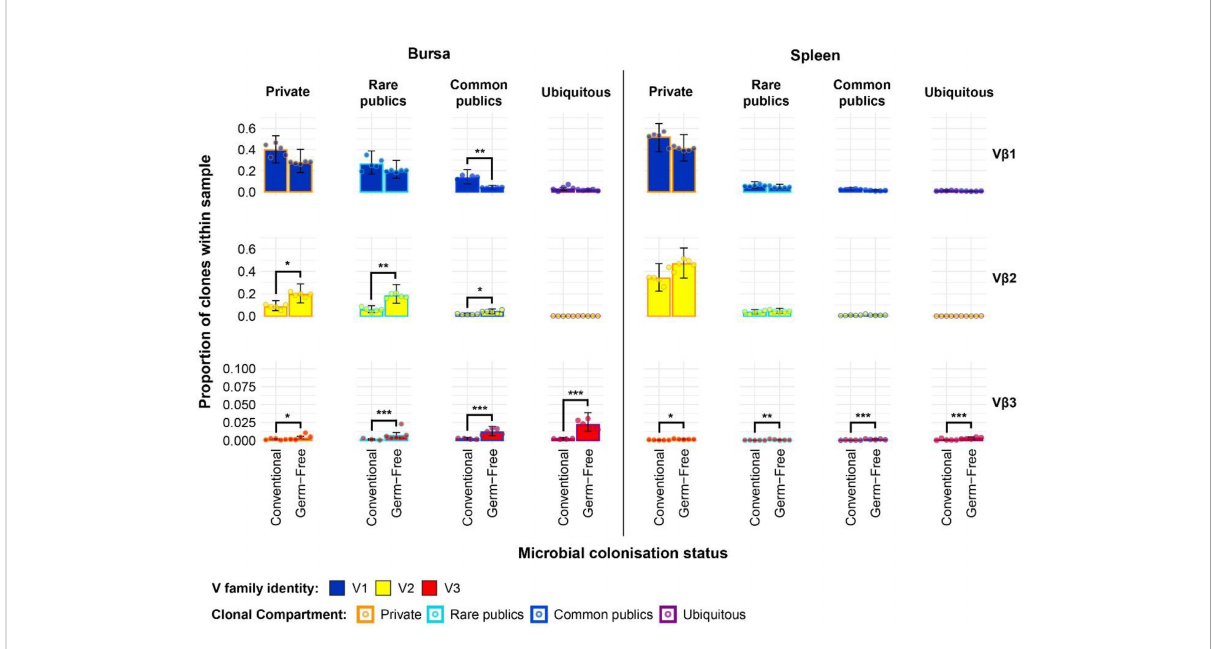
FIGURE 9 TCR b clone V family private and public compartments in the bursa and spleen based on different levels of clonal sharing between birds. Private (individual-restricted) clones are outlined in orange. Rare publics (shared between ≥ 2 and up to 5 birds) and are outlined in light blue. Common publics (shared between ≥ 5 and up to 9 birds) are outlined in dark blue. Ubiquitous publics (found in all birds which were incorporated in the analysis) are outlined in purple. V family identities are shown in blue (V b 1), yellow (V b 2), and red (V b 3). Dots represent individual bird observations of V family contributions to the public and private clonal compartments. Error bars show the 95% bootstrap con fi dence intervals for the point estimates generated from 1000 simulations of the model. Statistically signi fi cant differences between the model estimates are depicted above the plots based on their corresponding p-values: *p < 0.05; **p < 0.01, ***p <